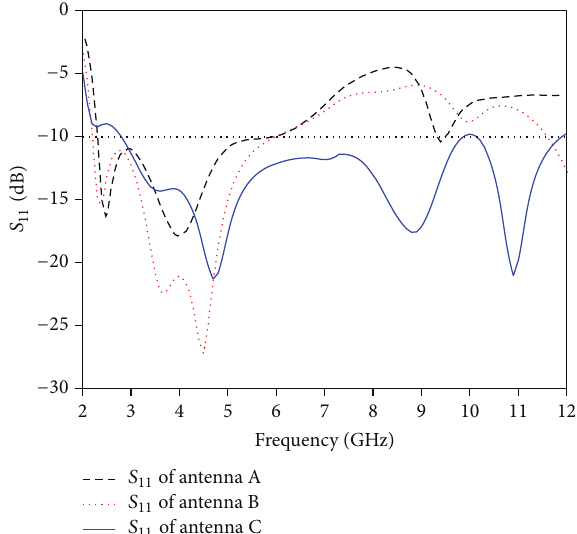
Figure 3: Magnitude of the scattering parameter S 11 versus frequency of the antennas depicted in Figure 2.